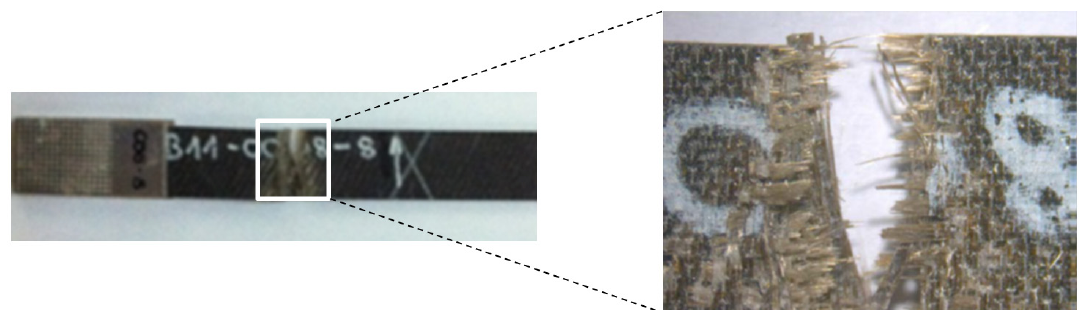
Figure 11: Fractured specimen with twill weave 2/2 fabric reinforcement in the warp direction. The area enclosed in the square box show details of the damage mechanism.